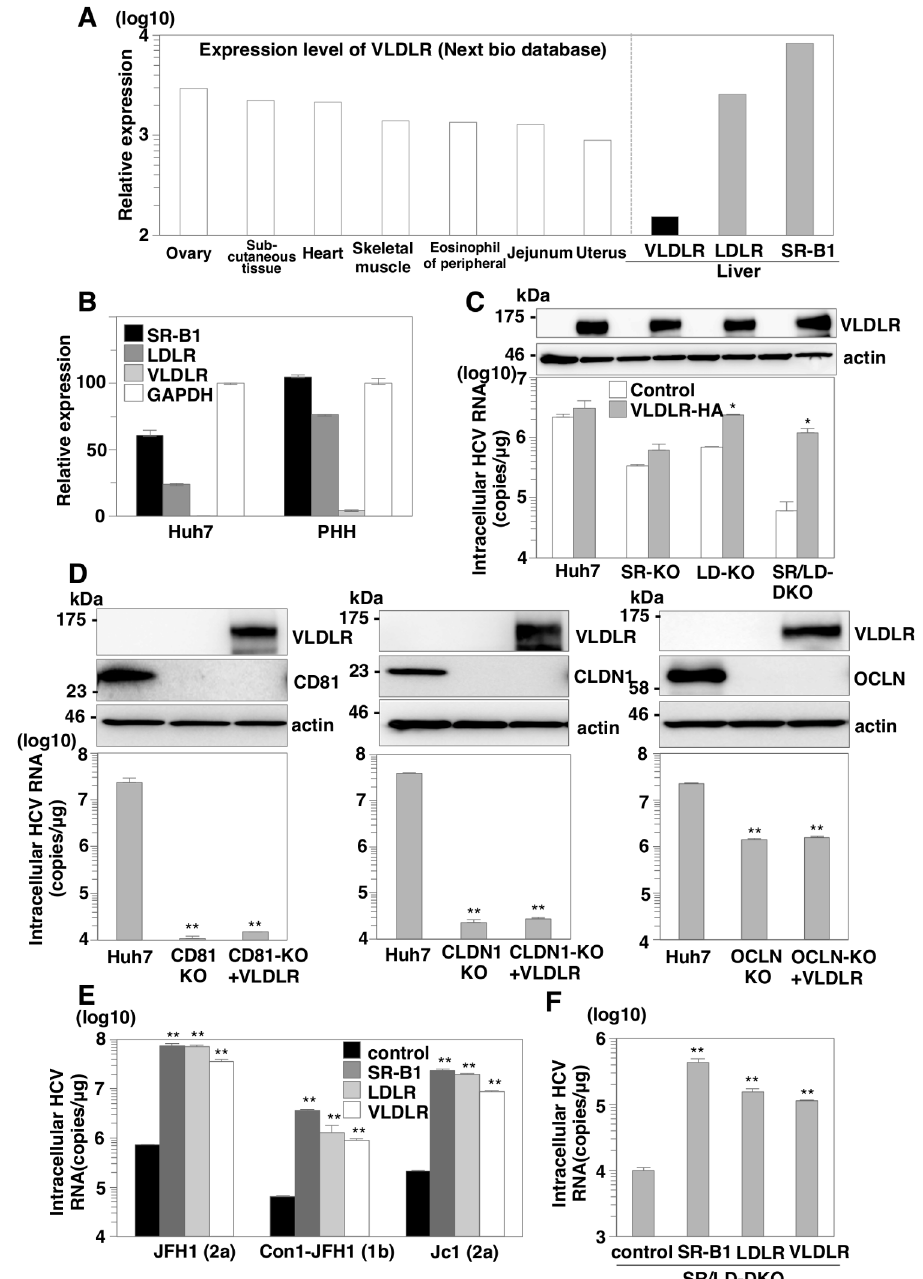
Fig 4. VLDLR has a similar role with SR-B1 and LDLR in HCV entry. (A) Relative mRNA expression of VLDLR in various tissues was determined using the NextBio Body Atlas application. (B) mRNA expression of SR-B1, LDLR, VLDLR and GAPDH in Huh7 cells and primary human hepatocyte (PHH) were determined by qRT-PCR. Relative expression levels of mRNA were calculated based on the expression level of GAPDH. (C) VLDLR-HA was exogenously expressed in parental, SR-KO, LD-KO and SR/LD-DKO Huh7 cells by infection with lentiviral vectors. Expressions of VLDLR in these cells were determined by immunoblotting analysis (upper panel). Parental, CD81 KO and SR/LD-DKO Huh7 cells expressing SR-B1, LDLR or VLDLR were infected with HCVcc at an MOI of 1 and intracellular HCV RNA levels were determined at 24 h post- infection (lower panel). (D) VLDLR-HA was exogenously expressed in CD81 KO, CLDN1 KO and OCLN KO Huh7 cells by infection with lentiviral vectors. Expressions of VLDLR, CD81, CLDN1 and OCLN in these cells were determined by immunoblotting analysis (upper panel). Cells were infected with HCVcc at an MOI of 1 and intracellular HCV RNA levels were determined at 24 h post-infection by qRT-PCR (lower panel).